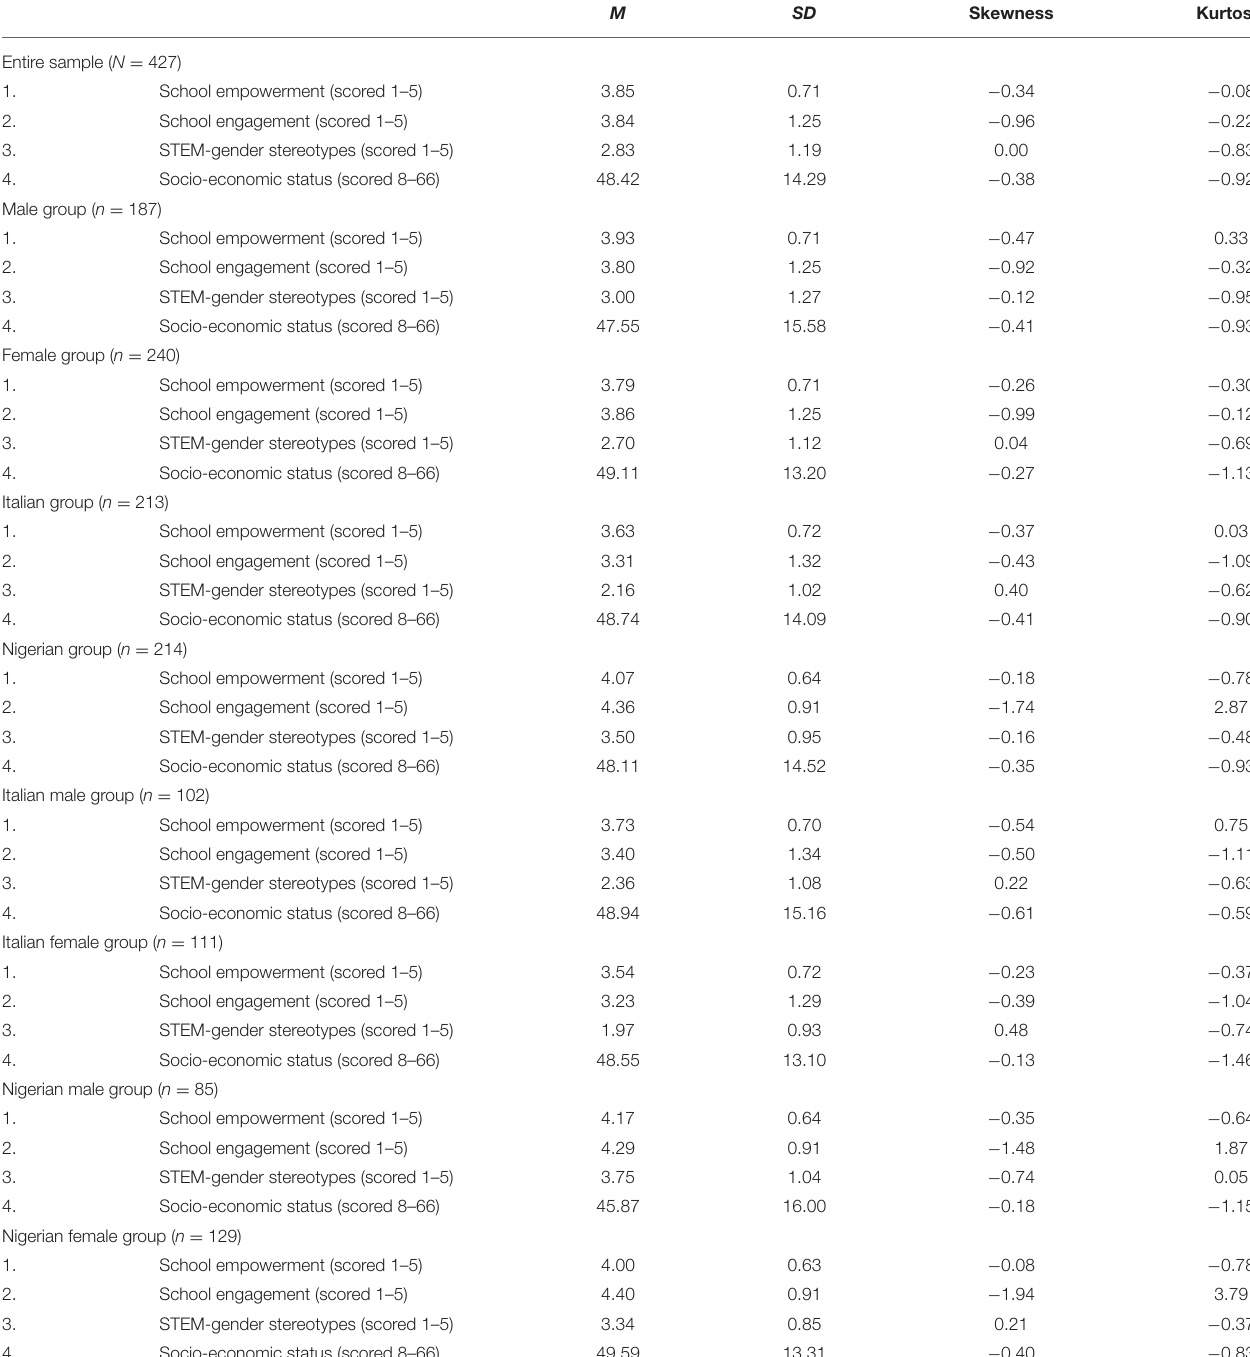
TABLE 1 | Means, standard deviations, skewness, and kurtosis for the key study variables for the entire sample, by gender, by national context and by gender and national context. M SD Skewness